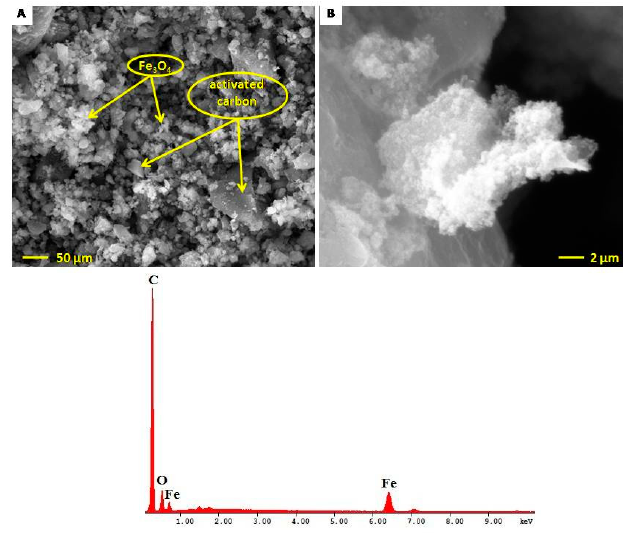
Figure 5. SEM-EDAX analysis of the Fe 3 O 4 @C matrix. ( A ) general overview—50 µ m scale; ( B ) topology—2 µ m scale; ( C ) EDAX.